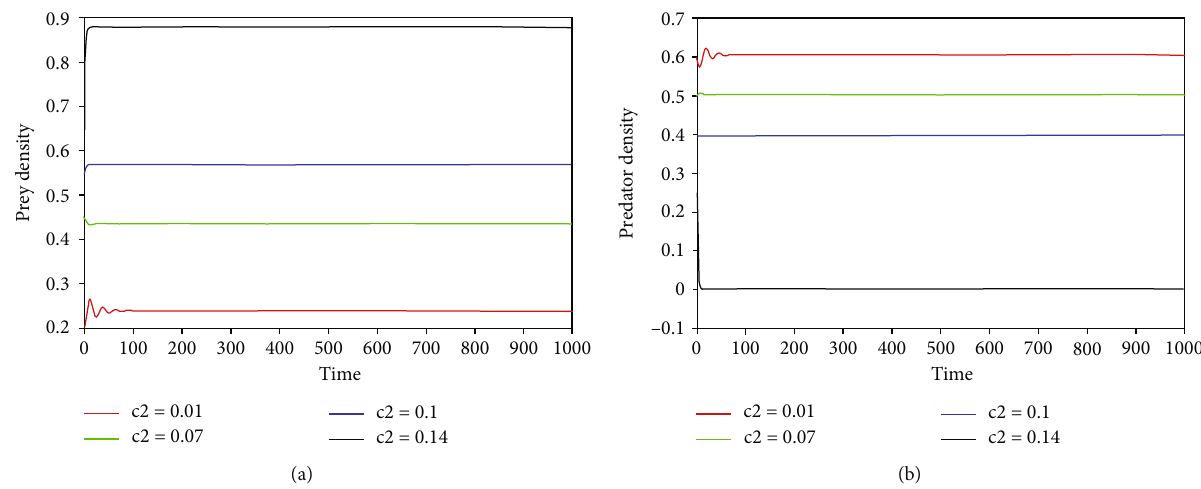
= 0 : 12, α = 0 : 25, and β = 0 : 2 and c = 1 2